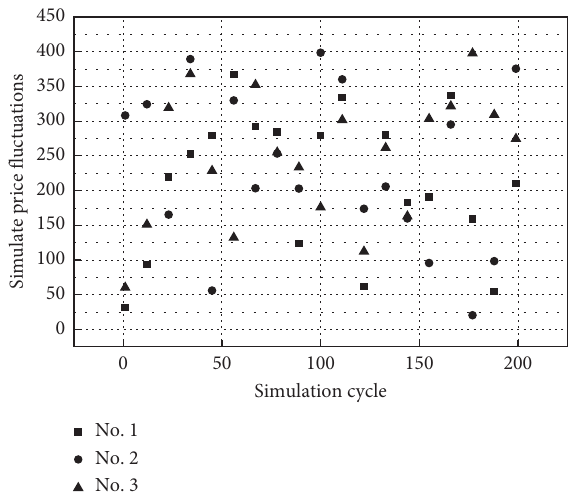
Figure 10: System reusability experiment stock price trend.